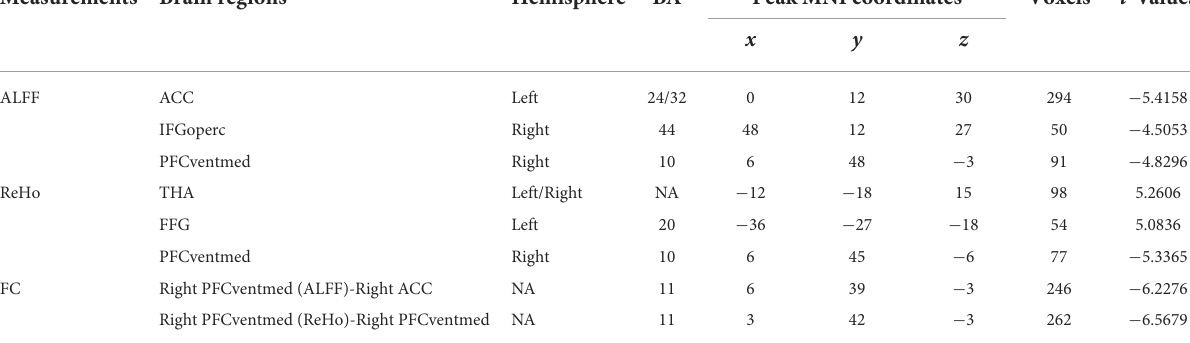
TABLE 2 Brain regions with aberrant ALFF, ReHo, and FC in BMP patients. Measurements Brain